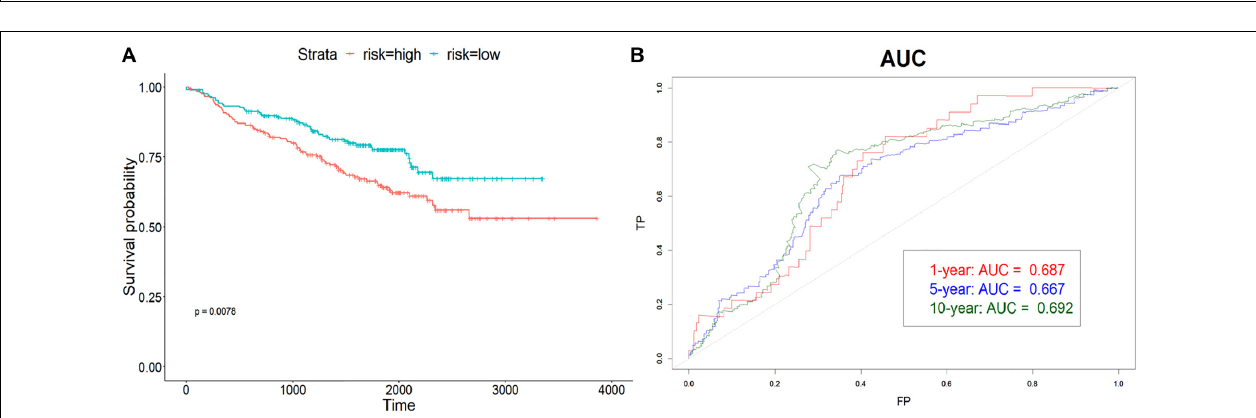
FIGURE 4 | Validation of the signature. (A) Kaplan–Meier curve of high-risk and low-risk groups in combined validation dataset. (B) The AUC of 1-, 5-, and 10-year OS. The validation data also predicted 10-year survival